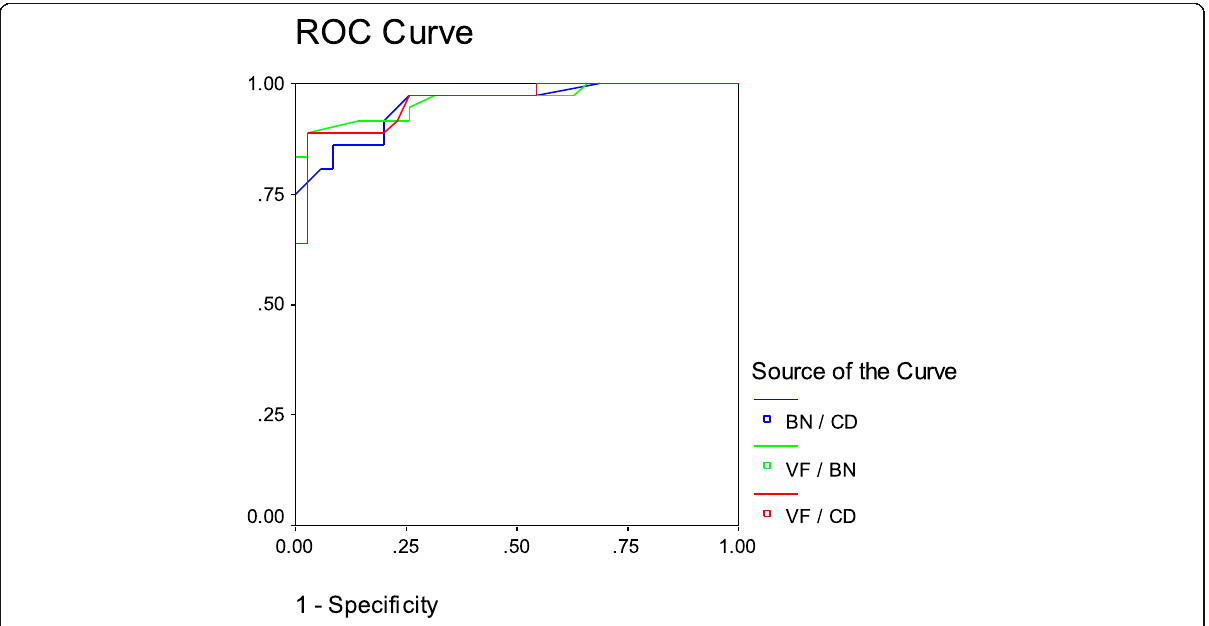
Fig. 2 ROC for different neurocognitive test combinations in educated